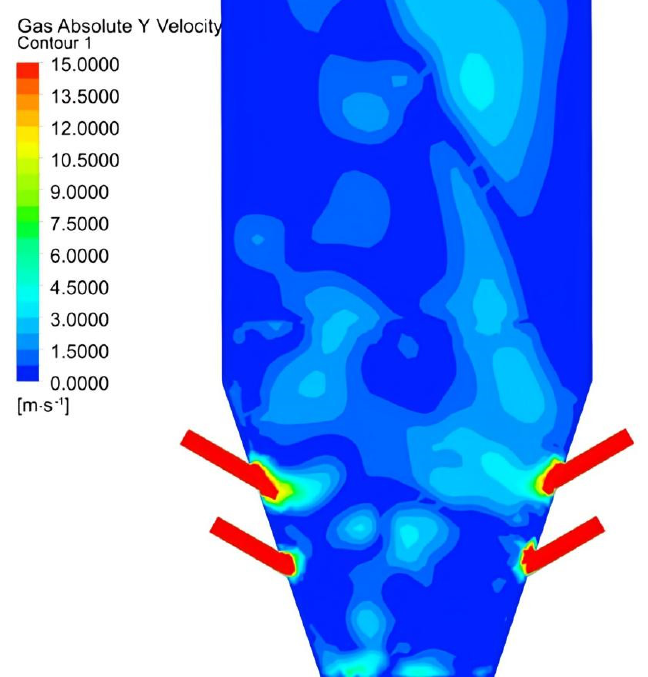
Figure 5. Calculated results of secondary air arrangement.